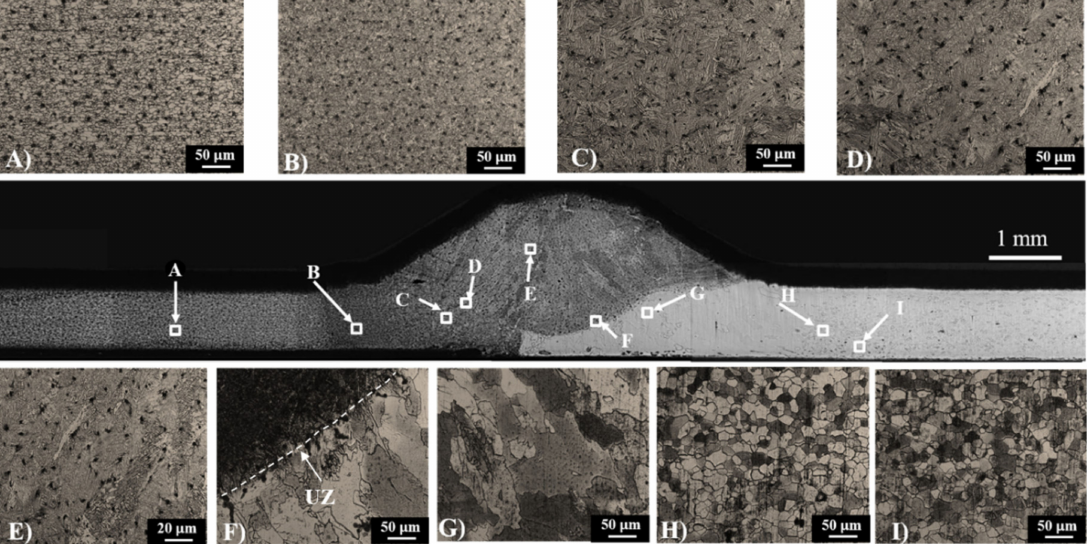
Figure 13. Microstructural changes generated by the welding process in dissimilar weld LC–DP: ( A ) TBMZ; ( B ) GRZ; ( C ) DP GGZ; ( D ) DP GGZ–FZ interface; ( E ) FZ; ( F ) LC GGZ–FZ interface; ( G ) LC GGZ; ( H , I ) LC